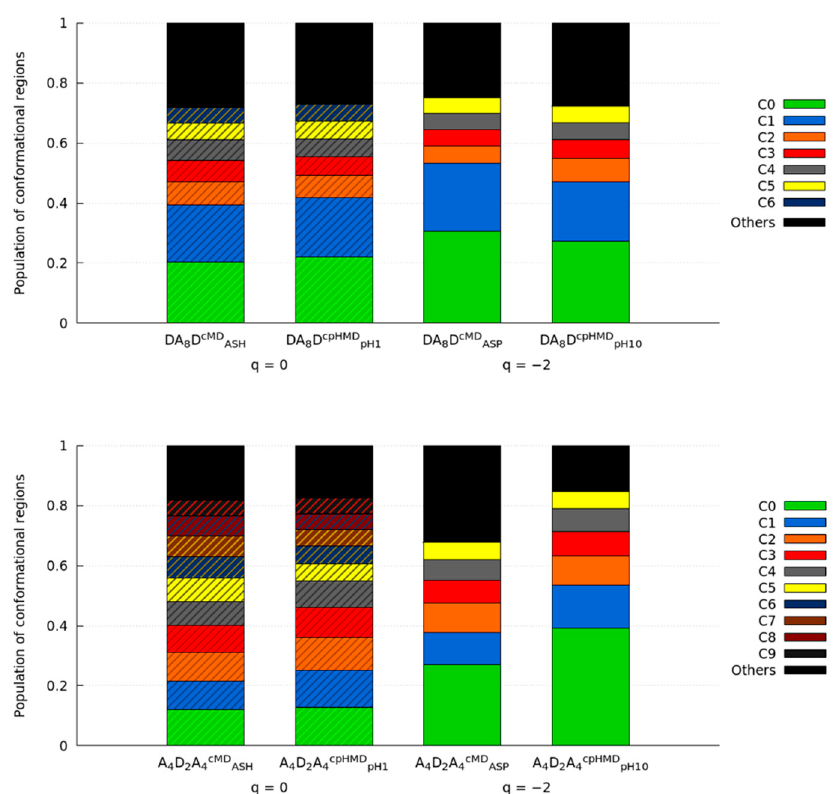
Figure 6. Representation of the clusters with a population ratio > 5% (DA 8 D and A 4 D 2 A 4 in the top and the bottom, respectively) in all simulation methods. Each system indicates the residue, the simulation method (in the superscript), and the pH (in the subscript, only the CPHMD simulations). Total charge of the tripeptide is indicated below the systems (q = − 2, 0). The box style (striped or solid) indicates those systems in the same protonation state, independently of the simulation method.